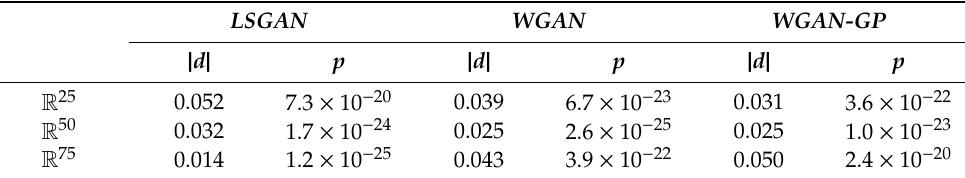
Table 5. Best obtained absolute di ff erence and p value calculations for robust equivalency testing. Values calculated comparing the original target distribution (DS3) with synthetic data generated by di ff erent GANs with di ff erent sized latent vectors as generator input.